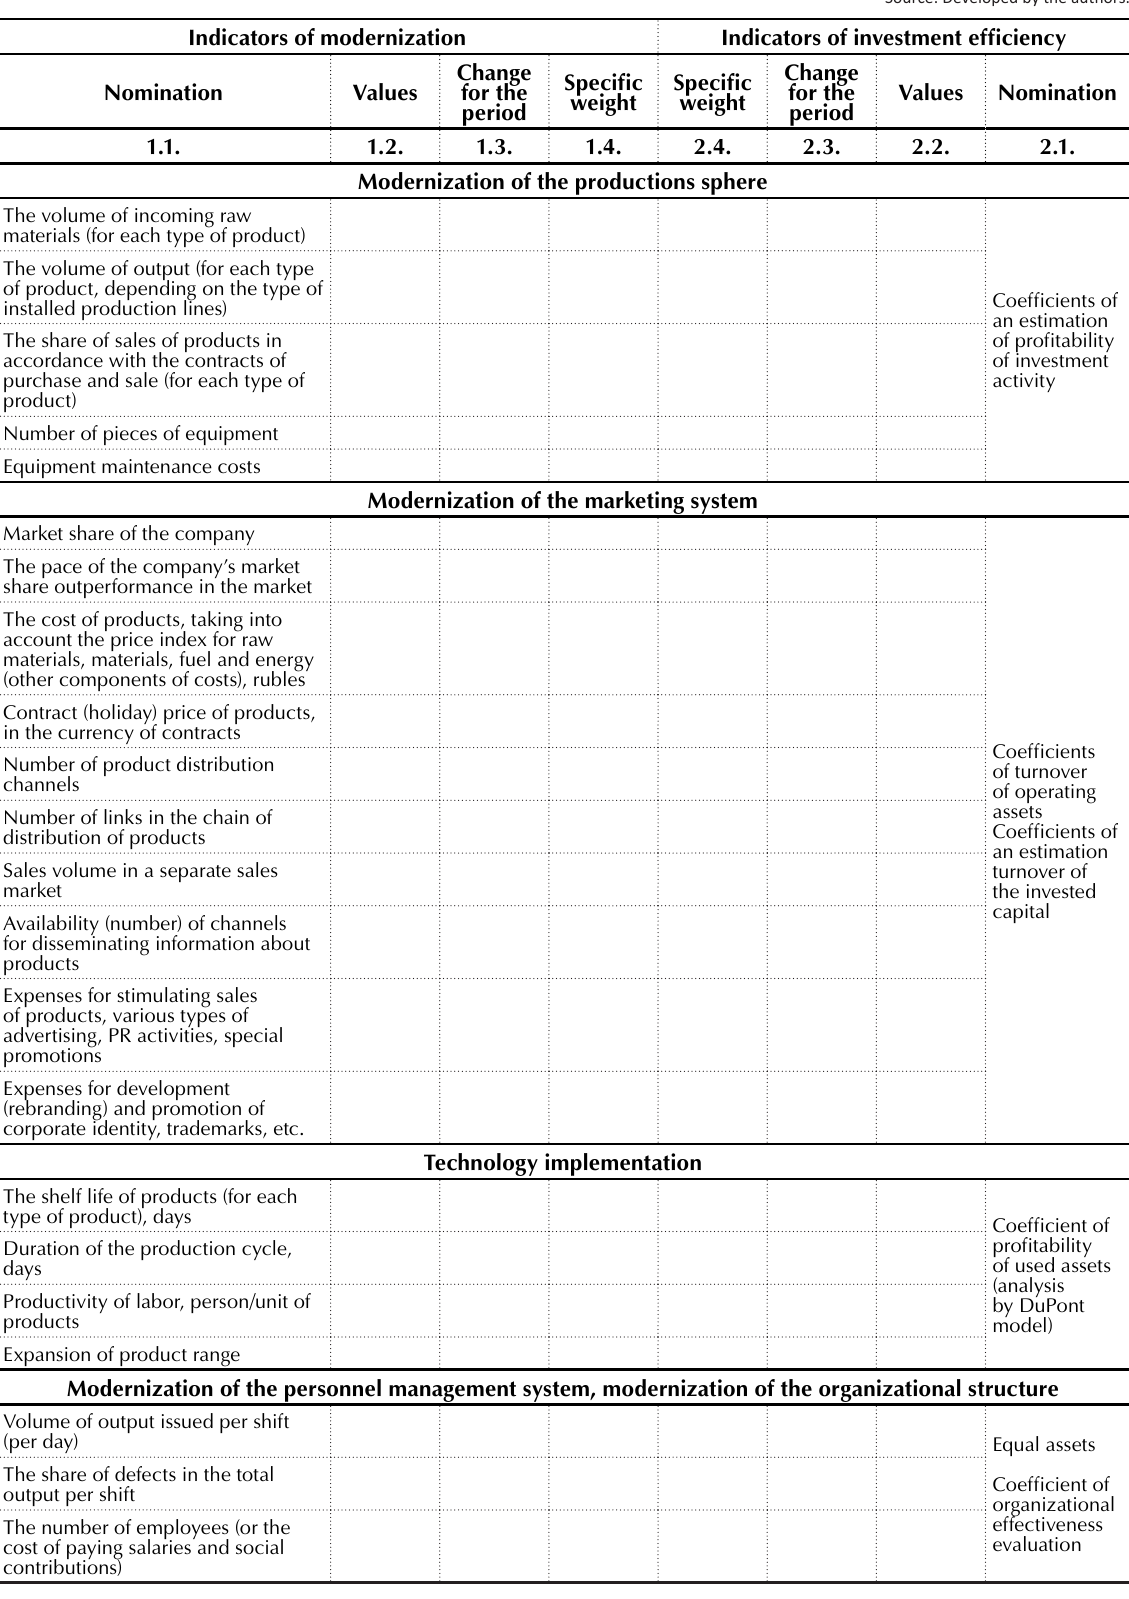
Source: Developed by the